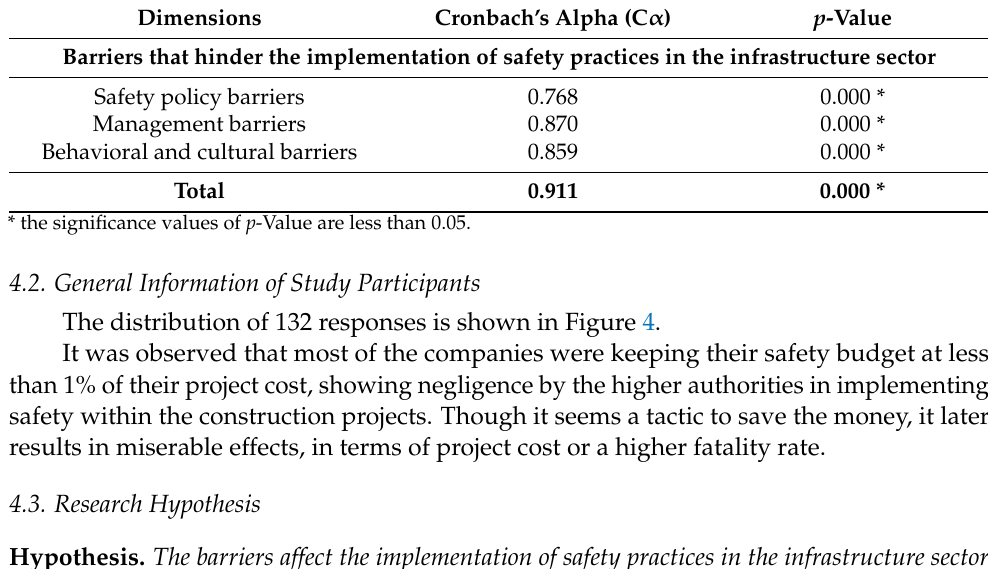
Table 4. Cronbach’s coefficient alpha for reliability (C α ). Dimensions Barriers that hinder the implementation of safety practices in the infrastructure